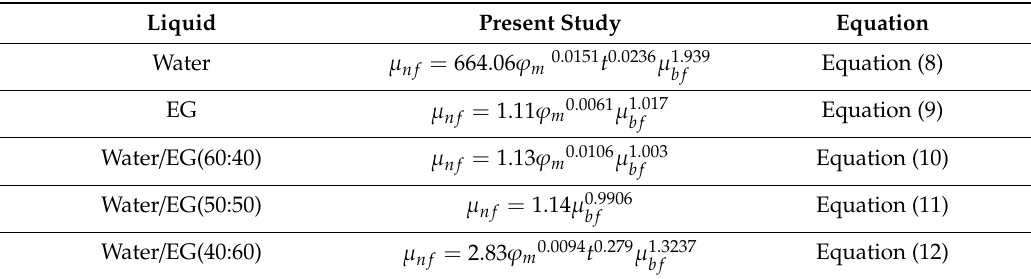
Table 2. Correlations for the dynamic viscosity of the tested